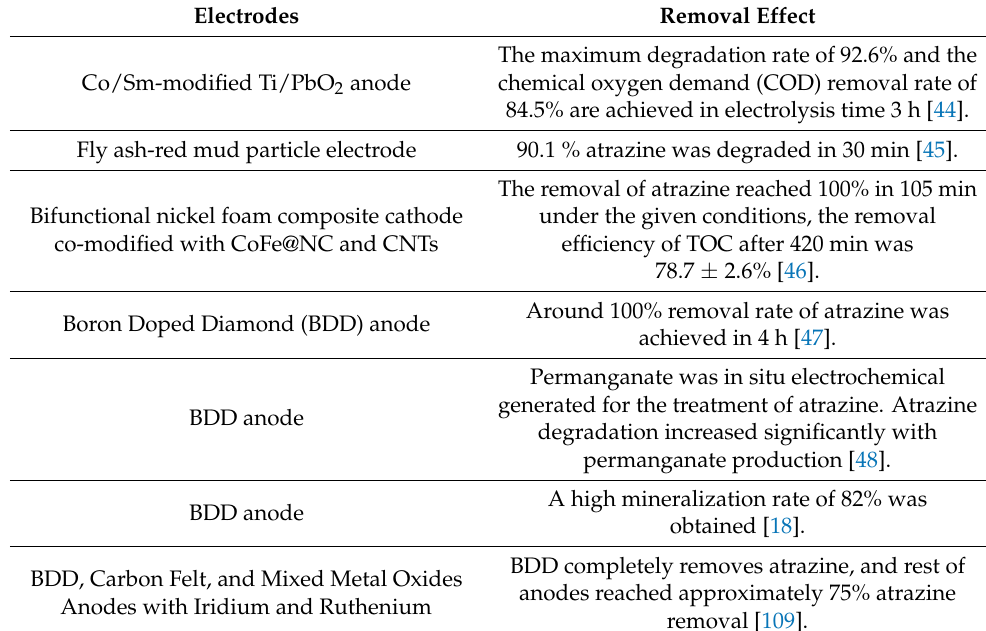
Table 3. Electrocatalytic oxidation of aqueous